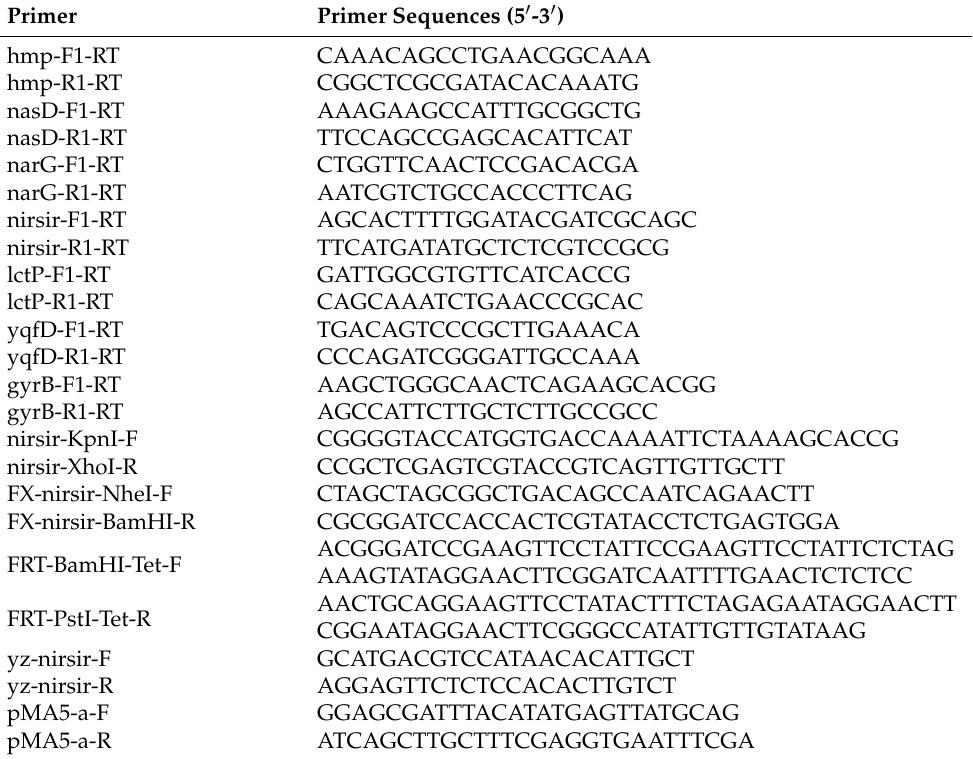
Table 2. Primers used in this study. Primer Primer Sequences (5 (cid:48) -3 (cid:48)